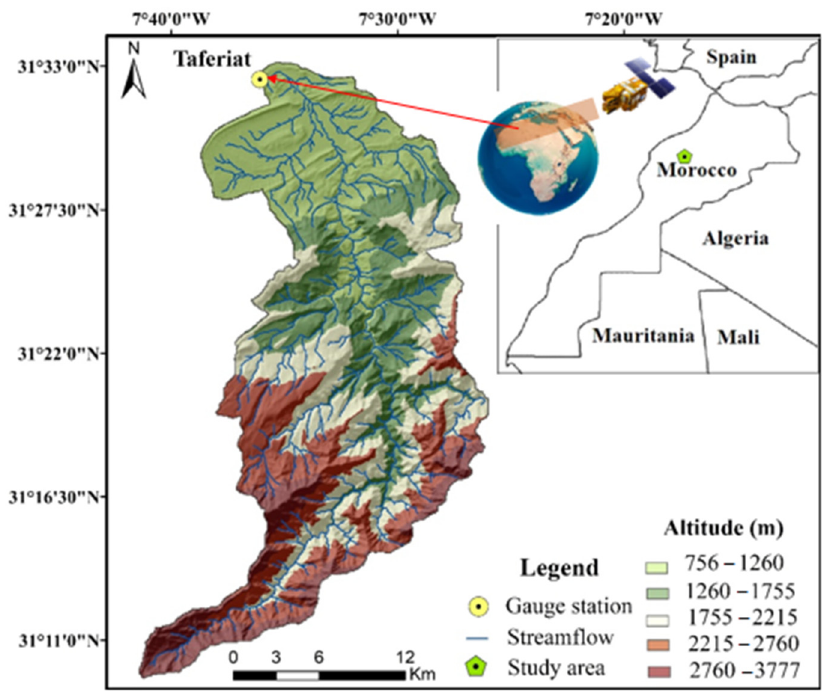
Figure 1. The geographical location of the Zat basin and rain gauge station used in the